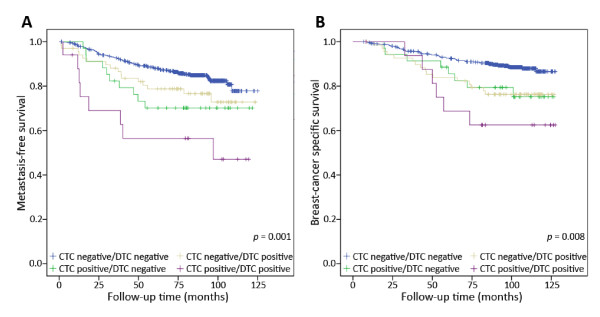
Kaplan-Meier plots demonstrating the effect of combining circulating and disseminated tumour cell status on metastasis-free survival (A) and breast-cancer specific survival (B). Those patients in whom tumour cells were detected in both the peripheral blood and bone marrow compartments have a significantly poorer survival compared to other groups (MFS = 3.5, P = 0.001; BCSS = 3.0, P = 0.008).